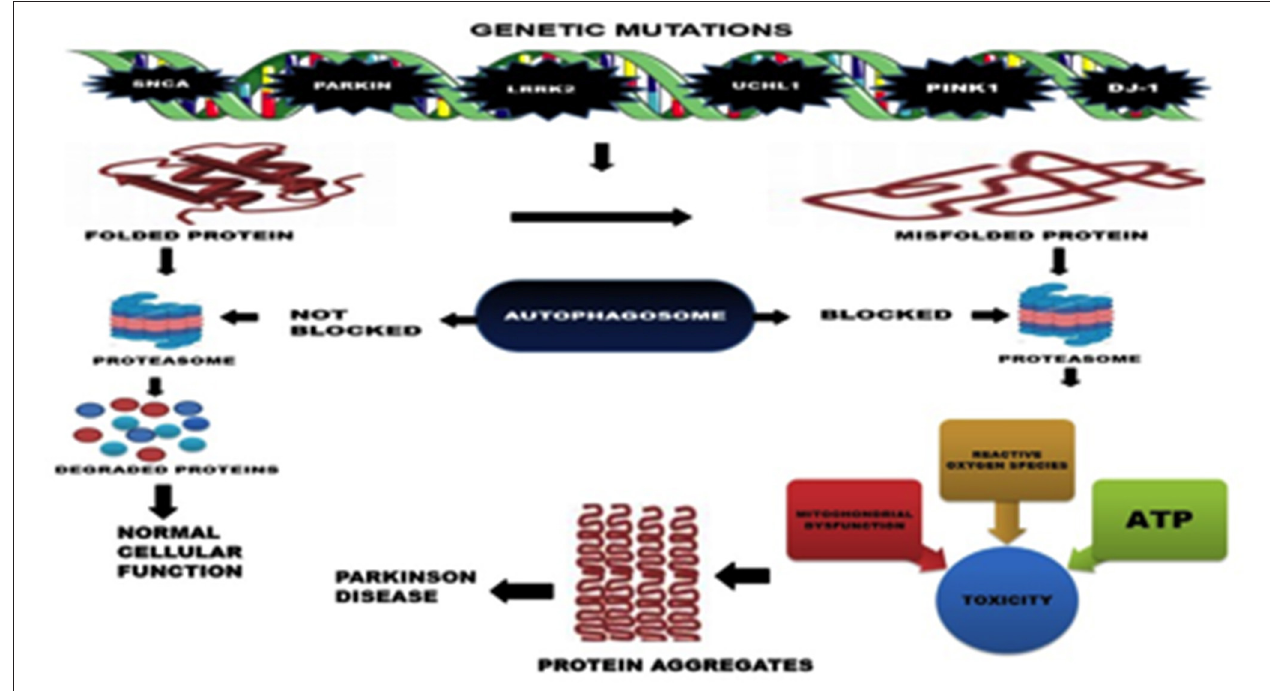
FIGURE 1 | Mechanisms of Neurodegeneration in